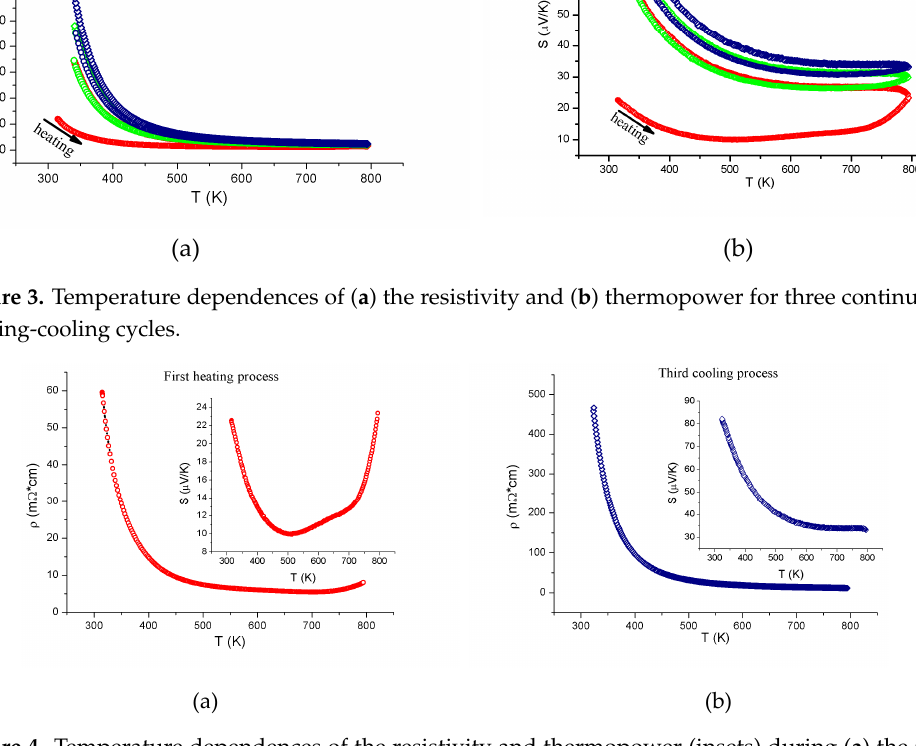
Figure 4. Temperature dependences of the resistivity and thermopower (insets) during ( a ) the first heating and ( b ) the third cooling.